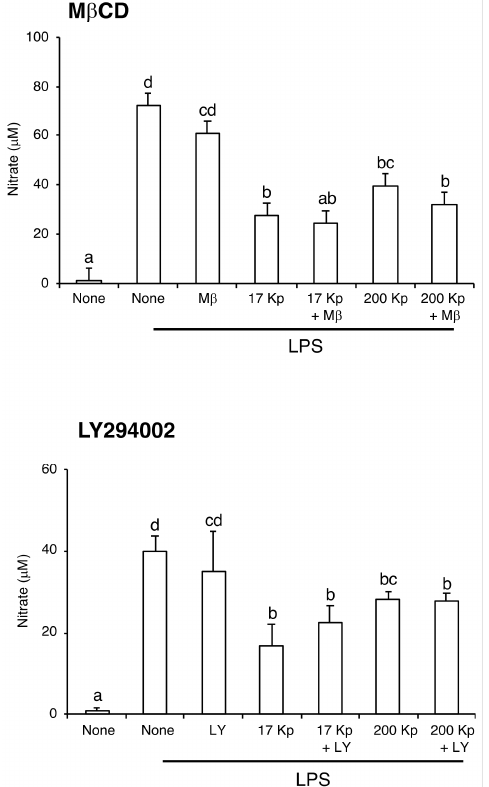
Figure 6. Effect of endocytosis inhibitors on the nitric oxide production in lipopolysaccharide (LPS)- treated RAW264 cells. Cell were treated with 400 µ g protein/mL of 17 Kp or 200 Kp for 24 h, then treated with or without inhibitors for 1 h. Finally, cells were treated with LPS (100 ng/mL) for 24 h. Nitric oxide was detected as nitrate by Griess method. Data are shown as mean ± SE for 3 experiments. Data without any common alphabetic letter are significantly different each other at p <